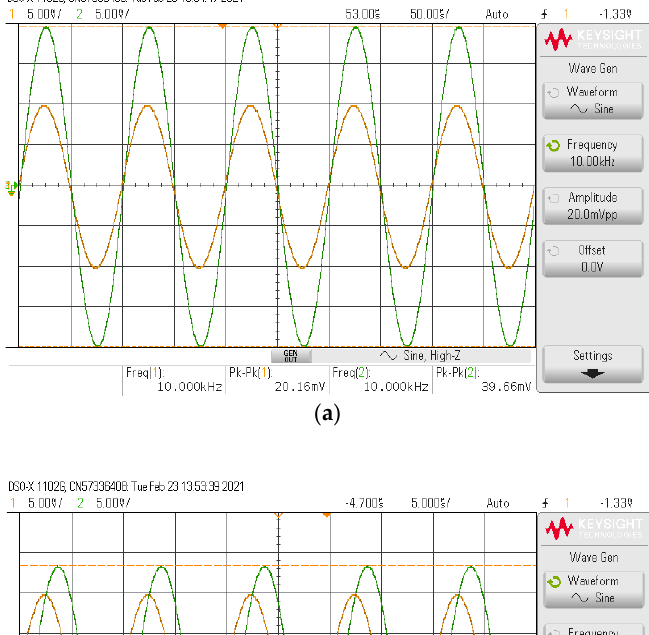
Figure 13. Frequency gain response of LP with different I B values.